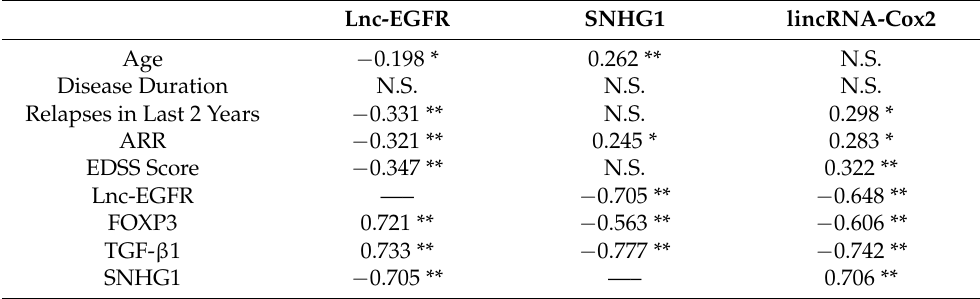
Table 2. Pearson’s correlation analysis of lncRNA (lnc-EGFR, SNHG1, and lincRNA-Cox2) levels with clinical characteristics and biochemical markers in RRMS patients.